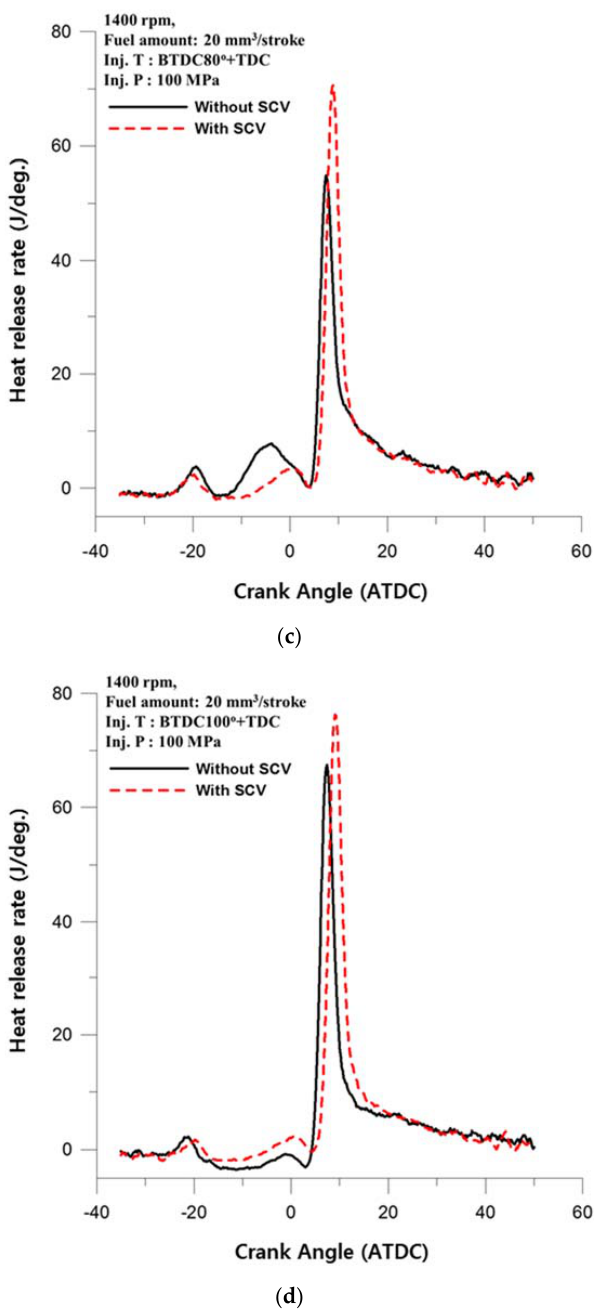
Figure 9. The effect on the SCV of the heat release rate during the 2nd injection (1400 rpm, injection amount: 20 mm 3 /stroke, 2nd injection timing: TDC). ( a ) Injection timing, 1st injection: BTDC 50°, 2nd injection: TDC; ( b ) Injection timing, 1st injection: BTDC 60°, 2nd injection: TDC; ( c ) Injection timing, 1st injection: BTDC 80°, 2nd injection: TDC; ( d ) Injection timing, 1st injection: BTDC 100°, 2nd injection: TDC.